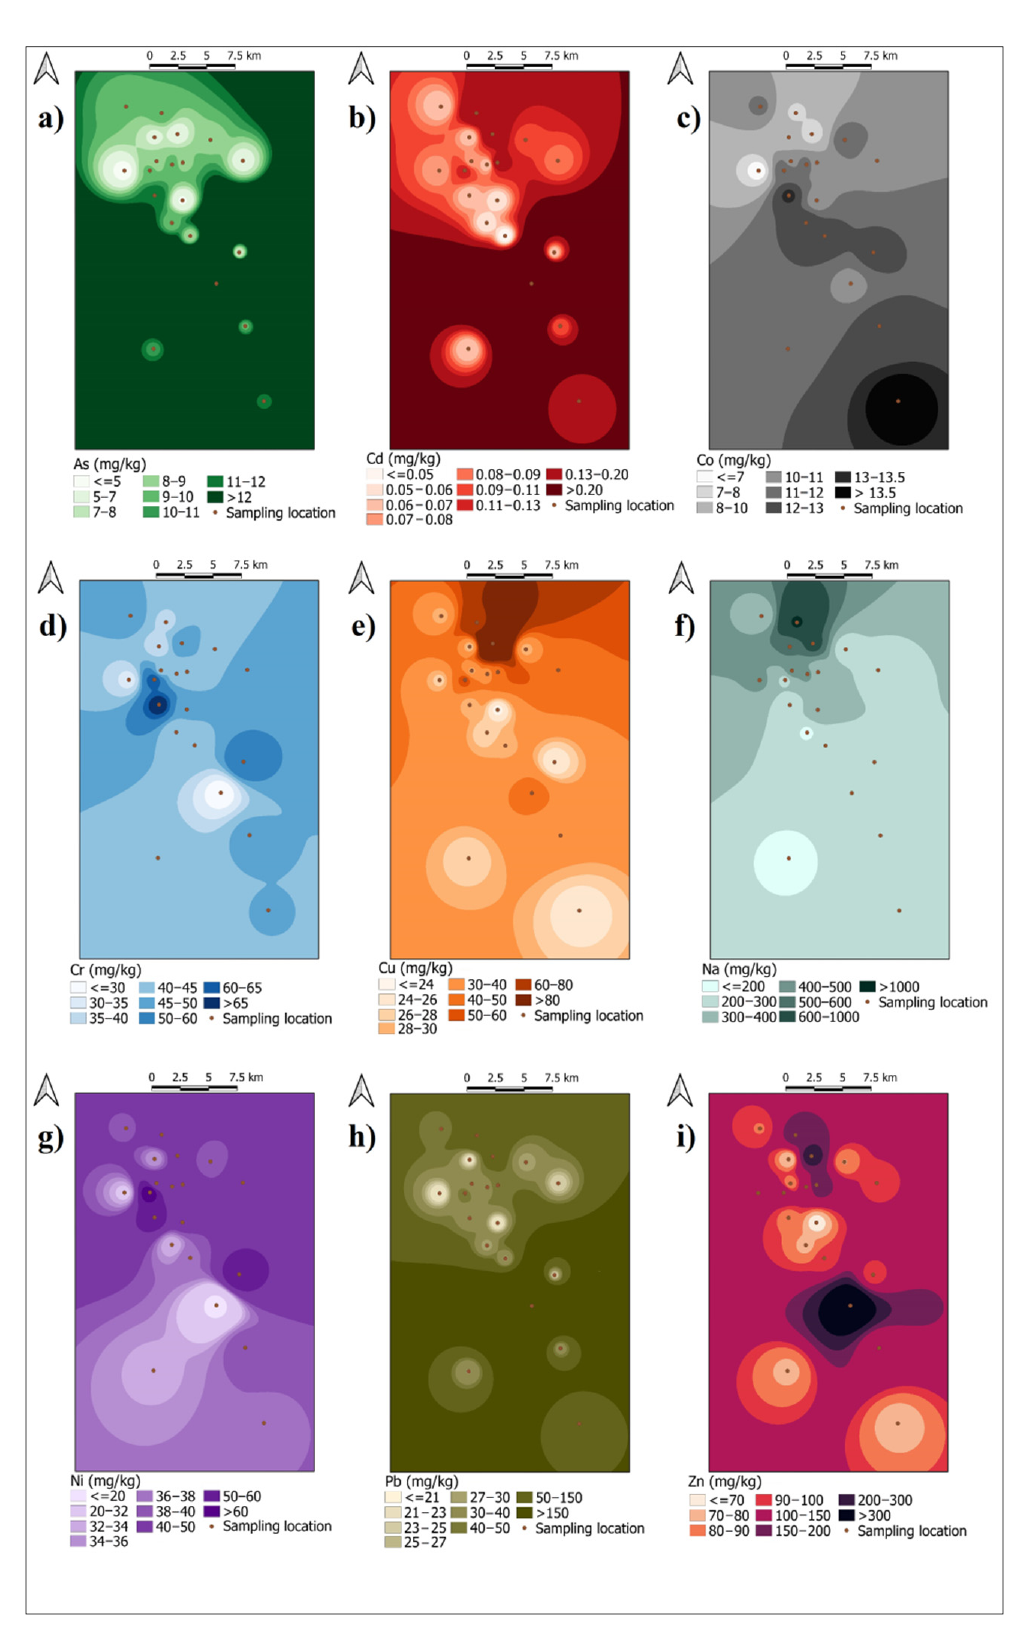
Figure 3. The spatial distribution of ( a )As, ( b ) Cd, ( c ) Co, ( d ) Cr, ( e ) Cu, ( f ) Na, ( g ) Ni, ( h ) Pb, and ( i ) Zn in